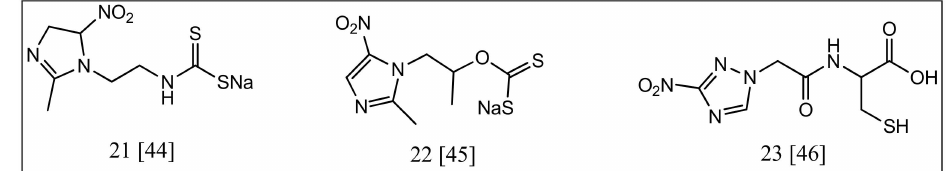
Figure 6. Molecular structure of ligands labelled with technetium using the nitrido core [44–46].